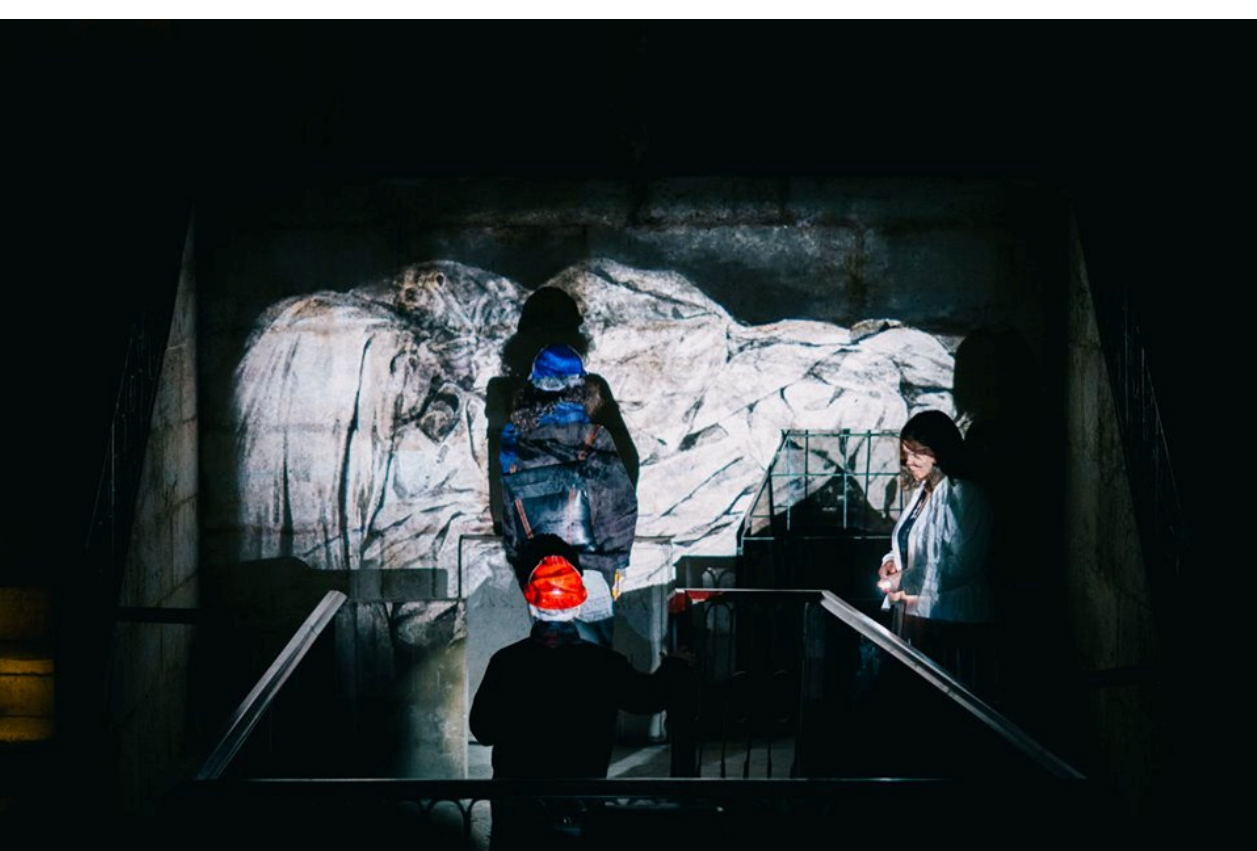
Figure 1. Place of Waiting . Video projection on the wall, by Irmã Lúcia special effects, while visitors are moving up to the next room. Mãe d’Água das Amoreiras Reservoir, Lisbon, 2019. © Joana Linda. are moving up to the next room. M ã e d’ Á gua das Amoreiras Reservoir, Lisbon, 2019. © Joana